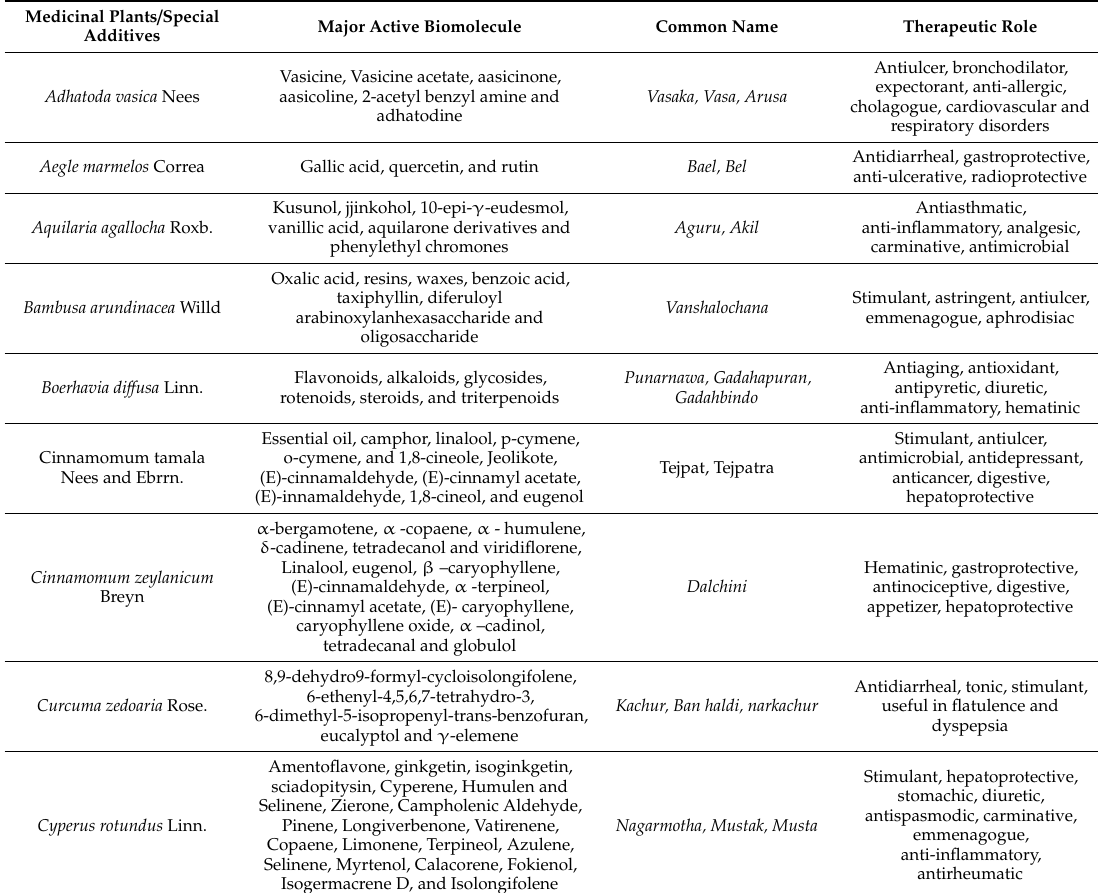
Figure 1. Key plant ingredients of Chyawanprash and their health benefits. Table 1. Ingredients of CP with their botanical identities and specific therapeutic roles.